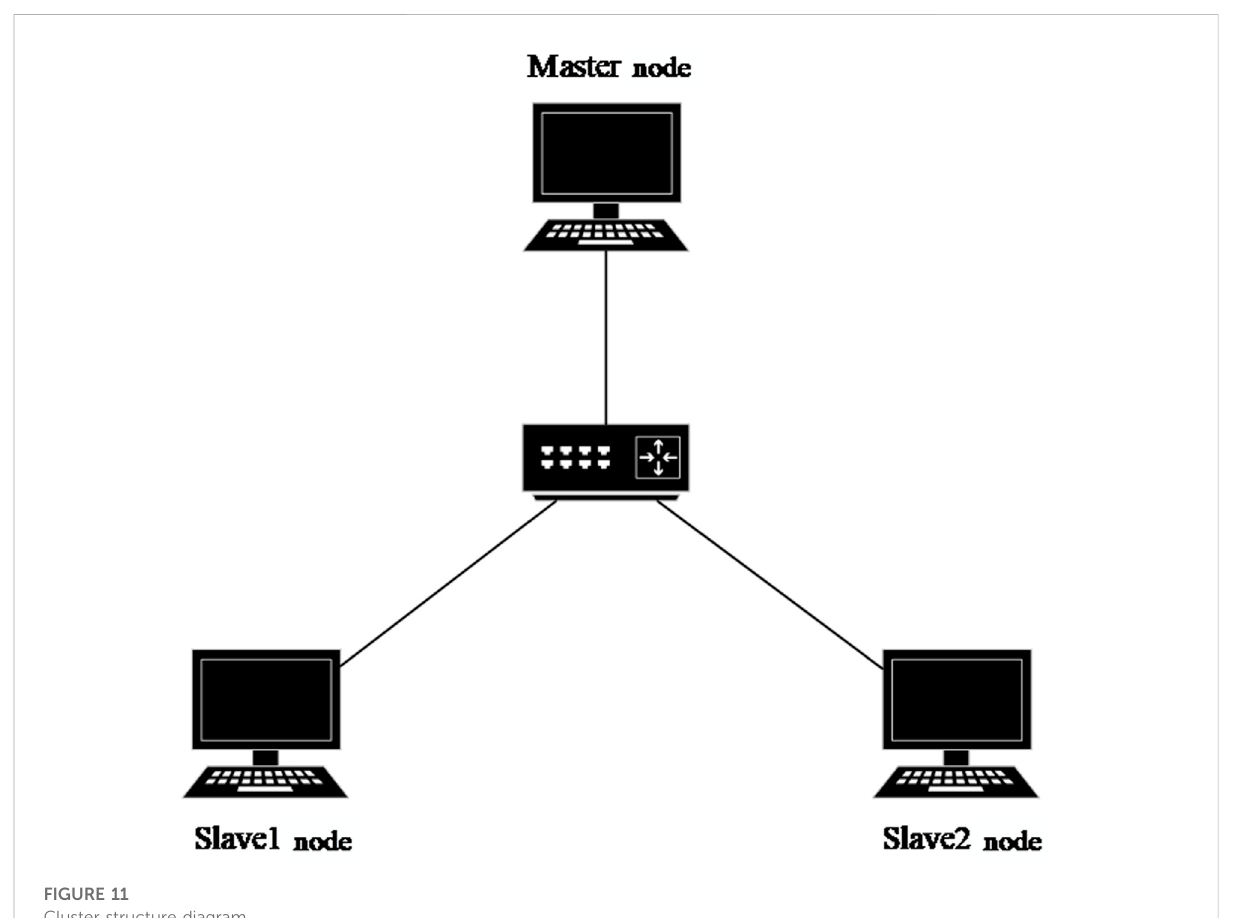
FIGURE 11 Cluster structure diagram.